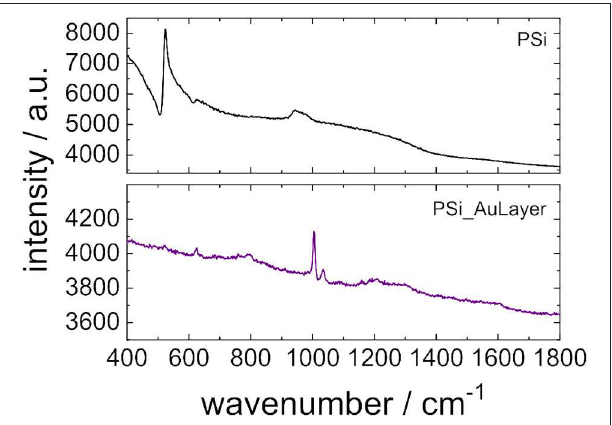
FIGURE 8 | Raman spectra of thiol-terminated polystyrene deposited on porous silicon films without (A) and with gold nanostructure on top (B) .